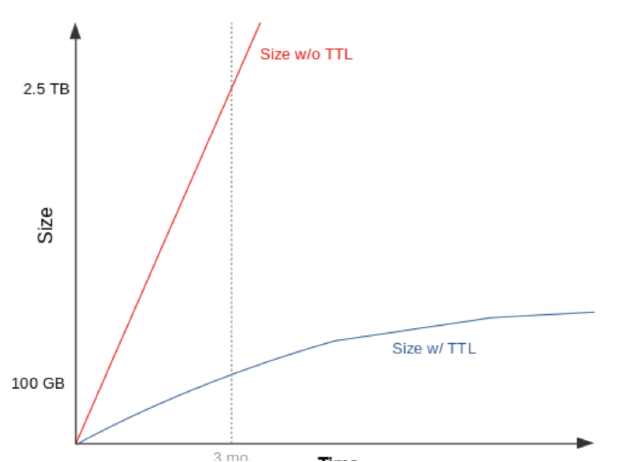
Figure 14. Storage requirements with and without time-to-live